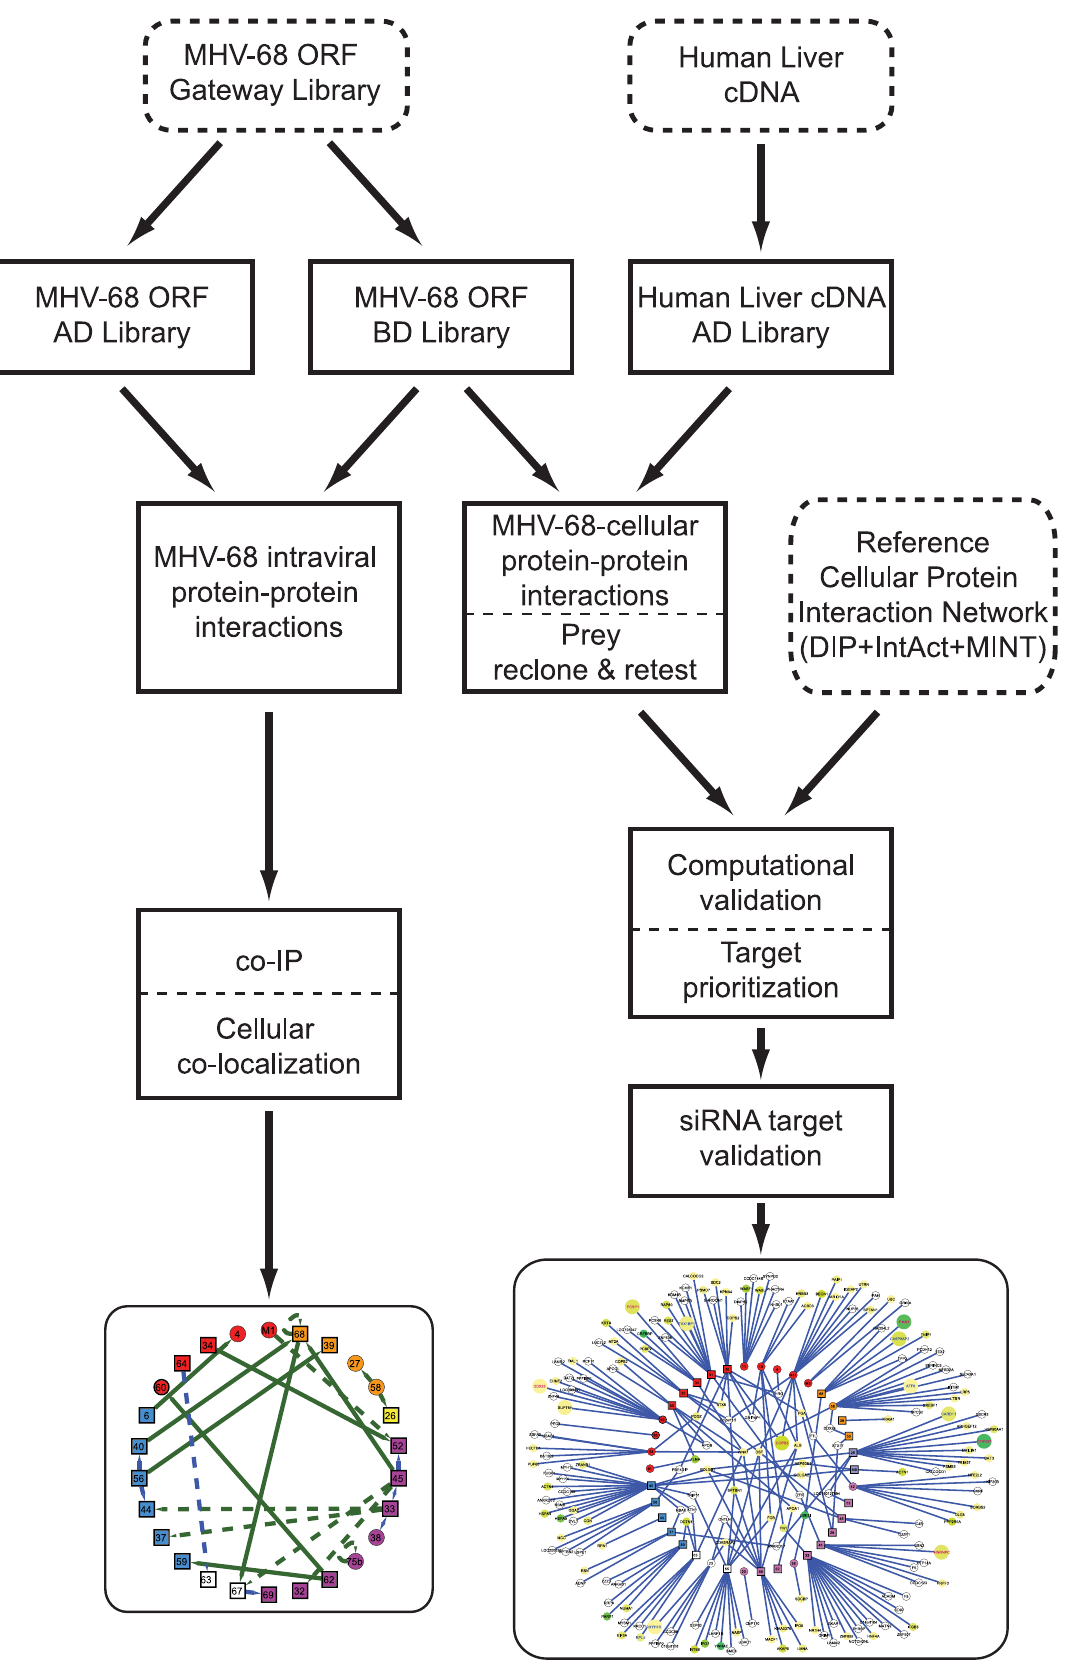
Figure1. Overview of the generation andvalidation of the MHV-68intra-viral andvirus-cellular protein-protein interactionnetworks. doi:10.1371/journal.ppat.1002297.g001 PLoS Pathogens |